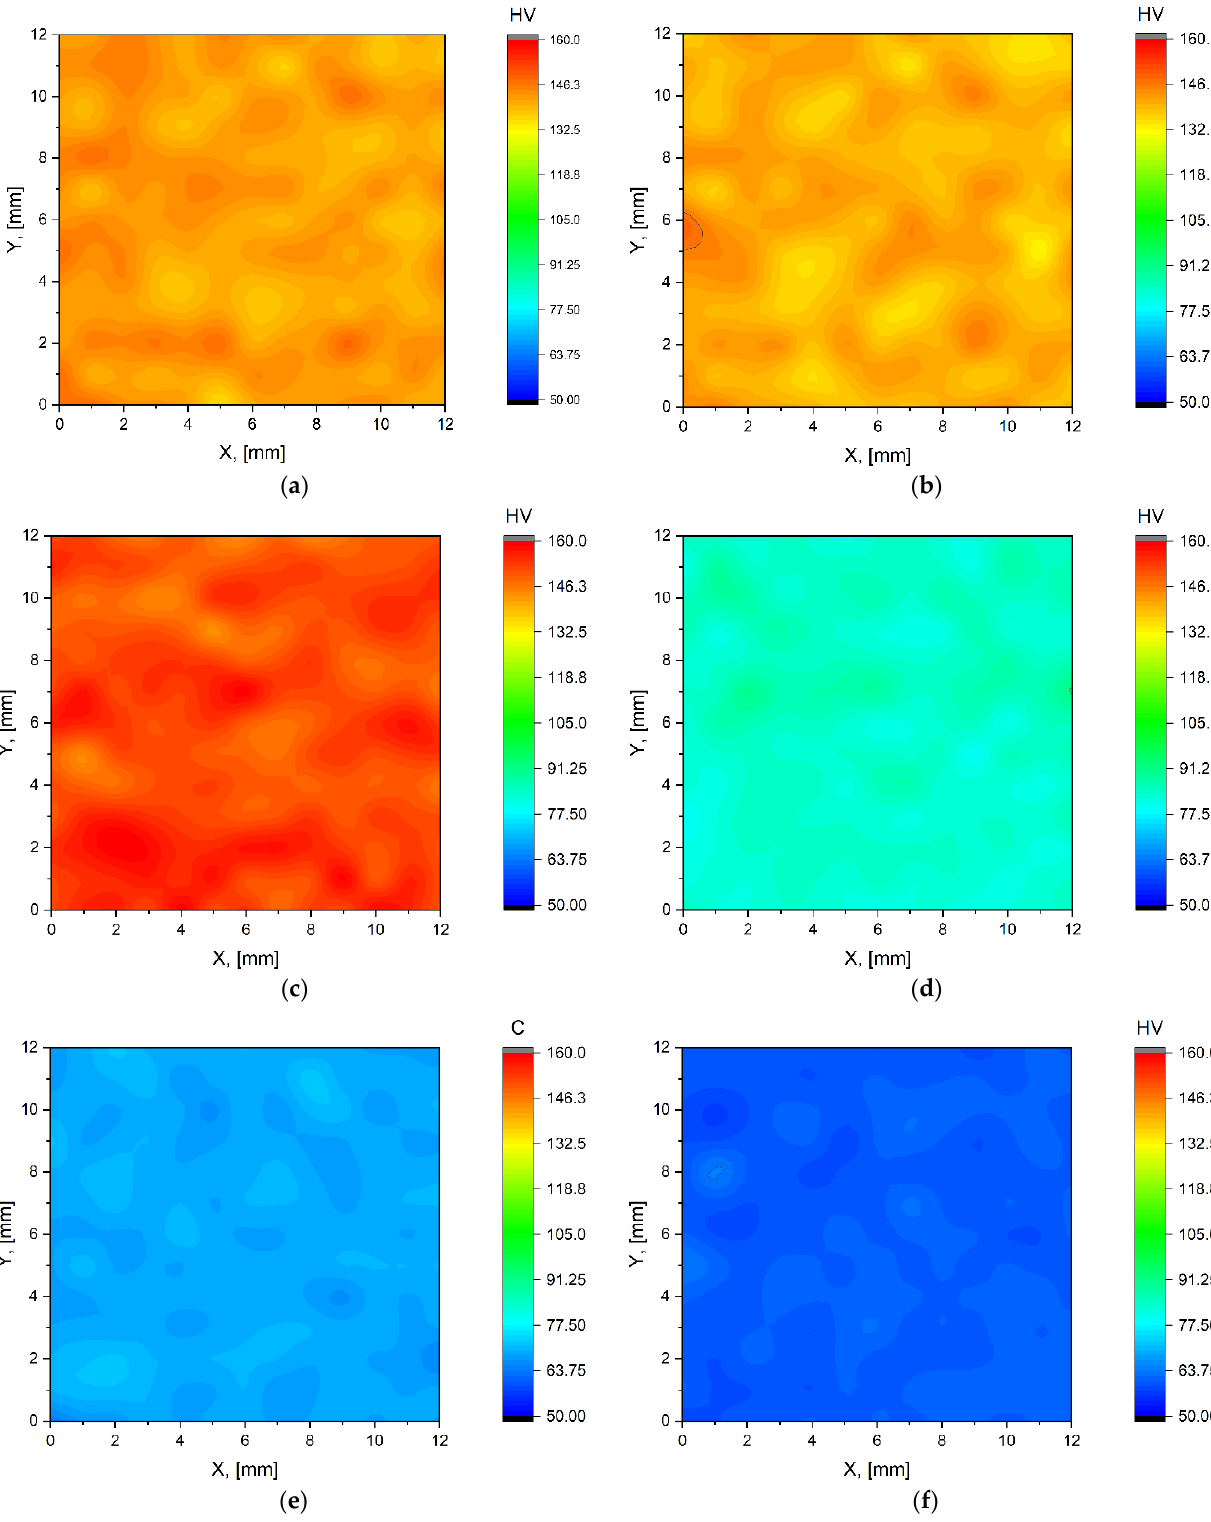
Figure 9. Vickers microhardness maps of studied samples ( a ) SLM; ( b ) HT280; ( c ) HT280E150; ( d ) SLME350; ( e ) SLME400; ( f ) SLME450. Table 3. Summary of mechanical properties obtained from hardness and compression tests.